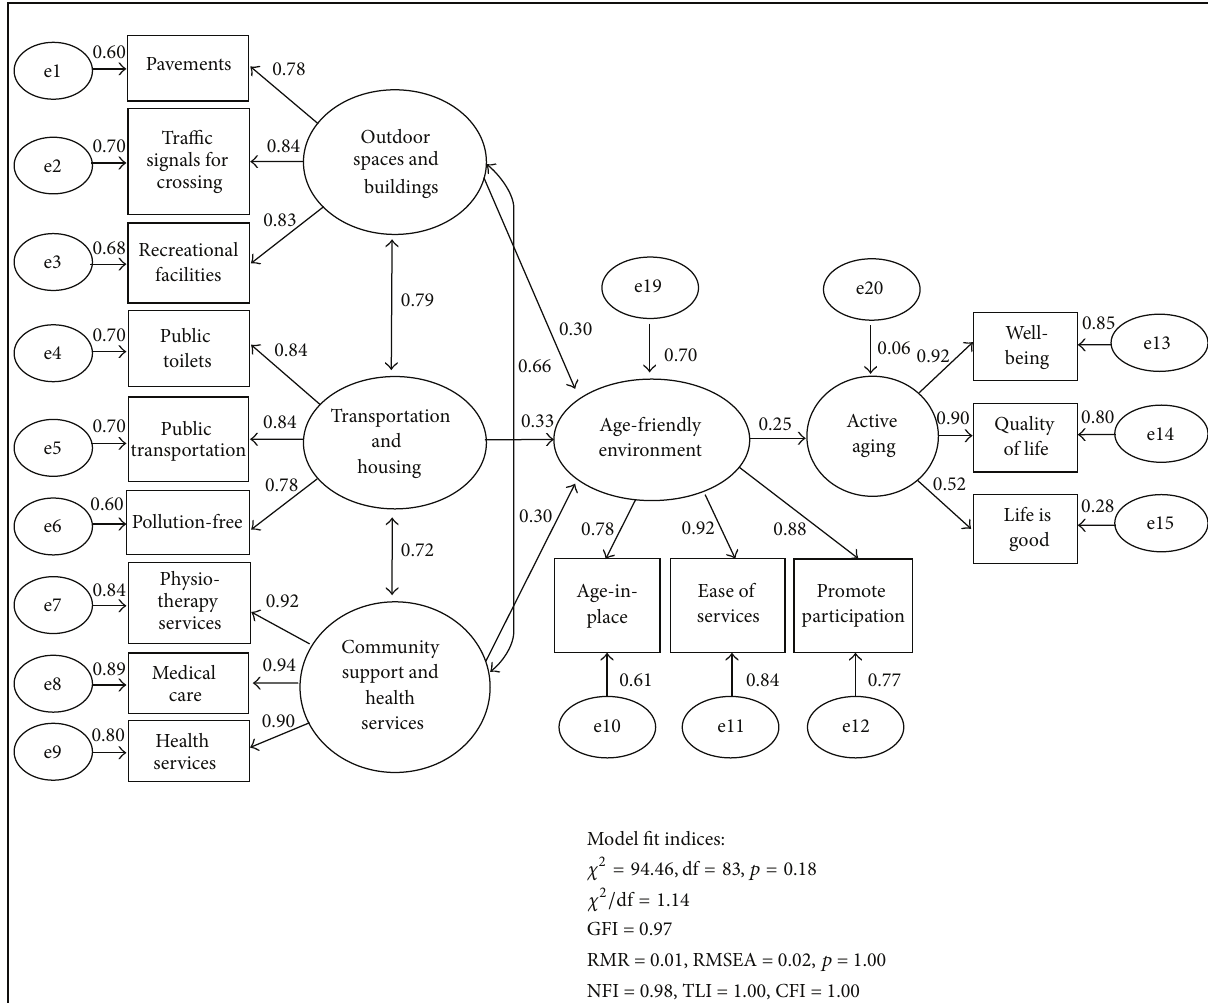
Figure 2: Structural model of age-friendly environment and active